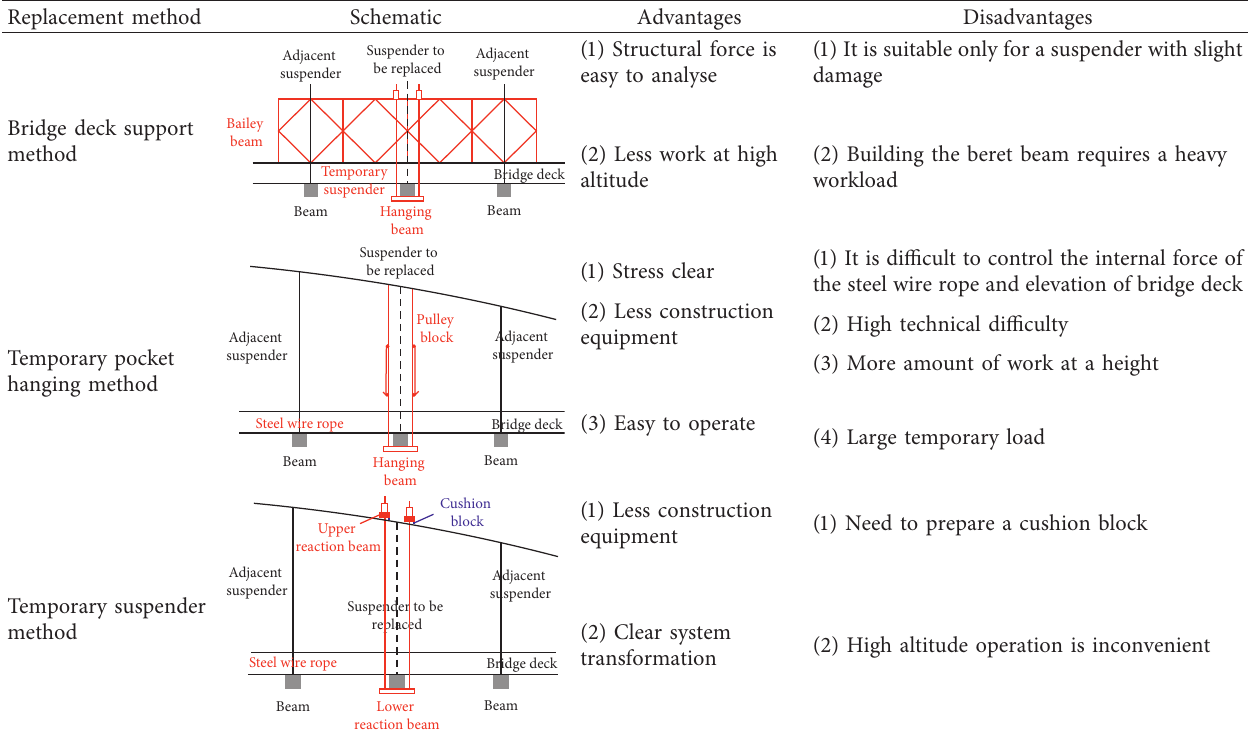
Table 1: Suspender replacement